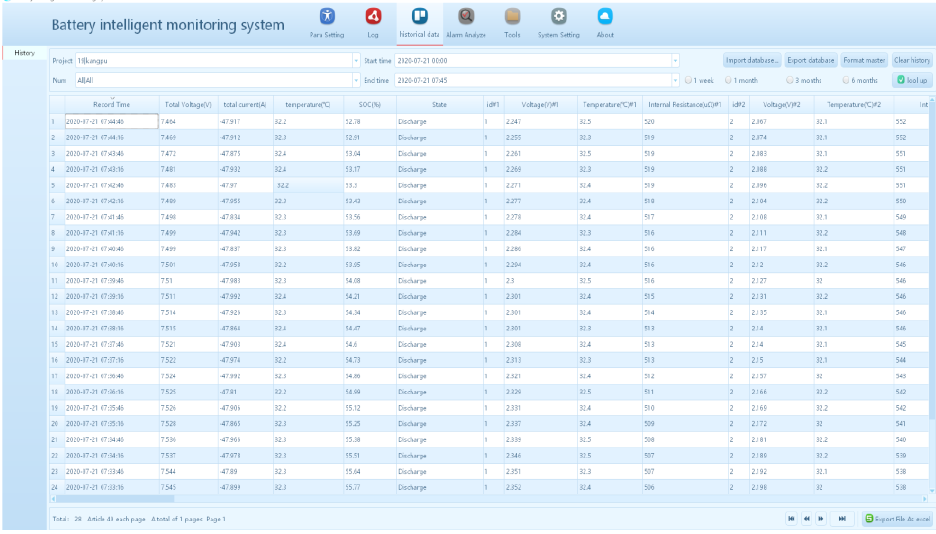
Figure 14. Software interface of the VRLA battery intelligent monitoring system.